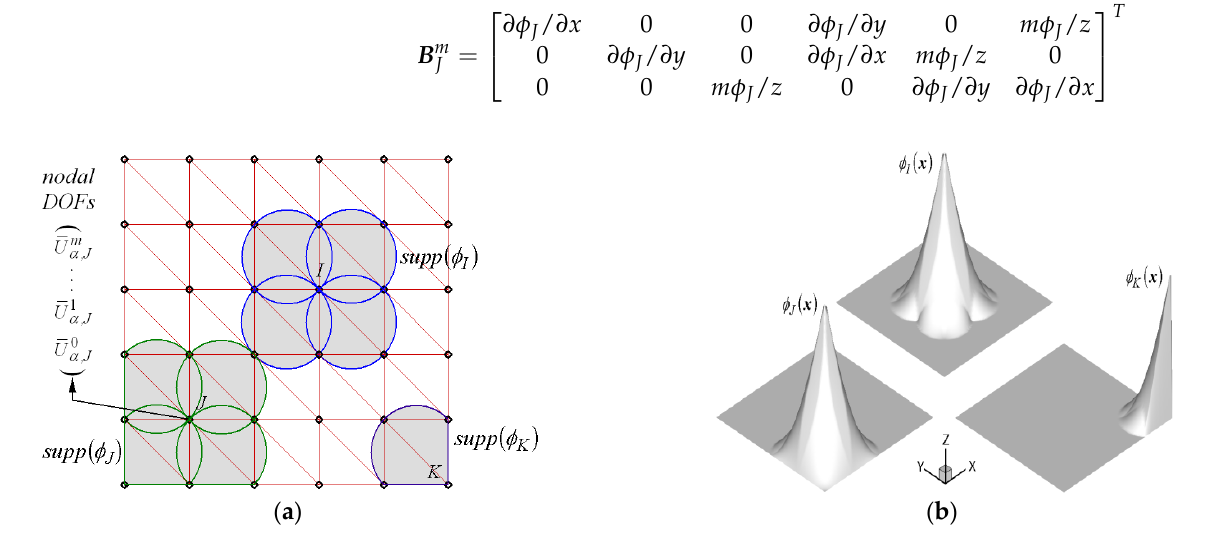
Figure 3. Natural element method: ( a ) NEM grid, ( b ) Laplace interpolation functions. Then, substituting Equations (12)–(15) into the variational form [29] of the free vibra- tion problem (9) generated the linear modal